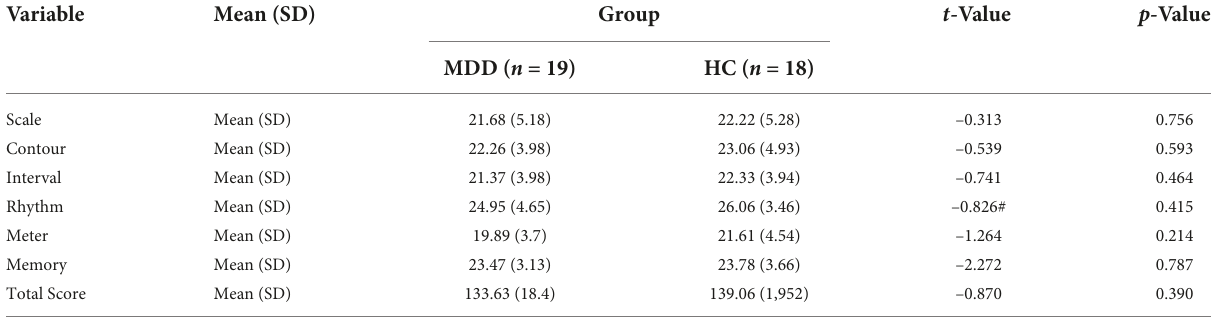
TABLE 5 Comparison between MDD and HC groups on montreal battery of